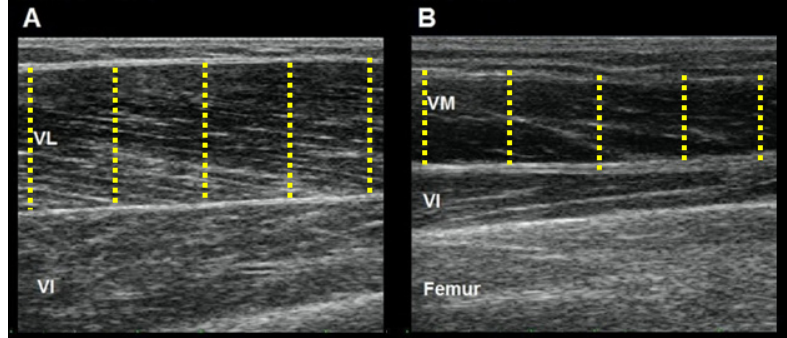
Figure 2. Ultrasonography images of vastus lateralis (A) and vastus medialis (B) from a representative participant. The vertical dashed lines represent the five measures of the target muscle thickness in each image. VM = vastus medialis; VL = vastus medialis; VI = vastus